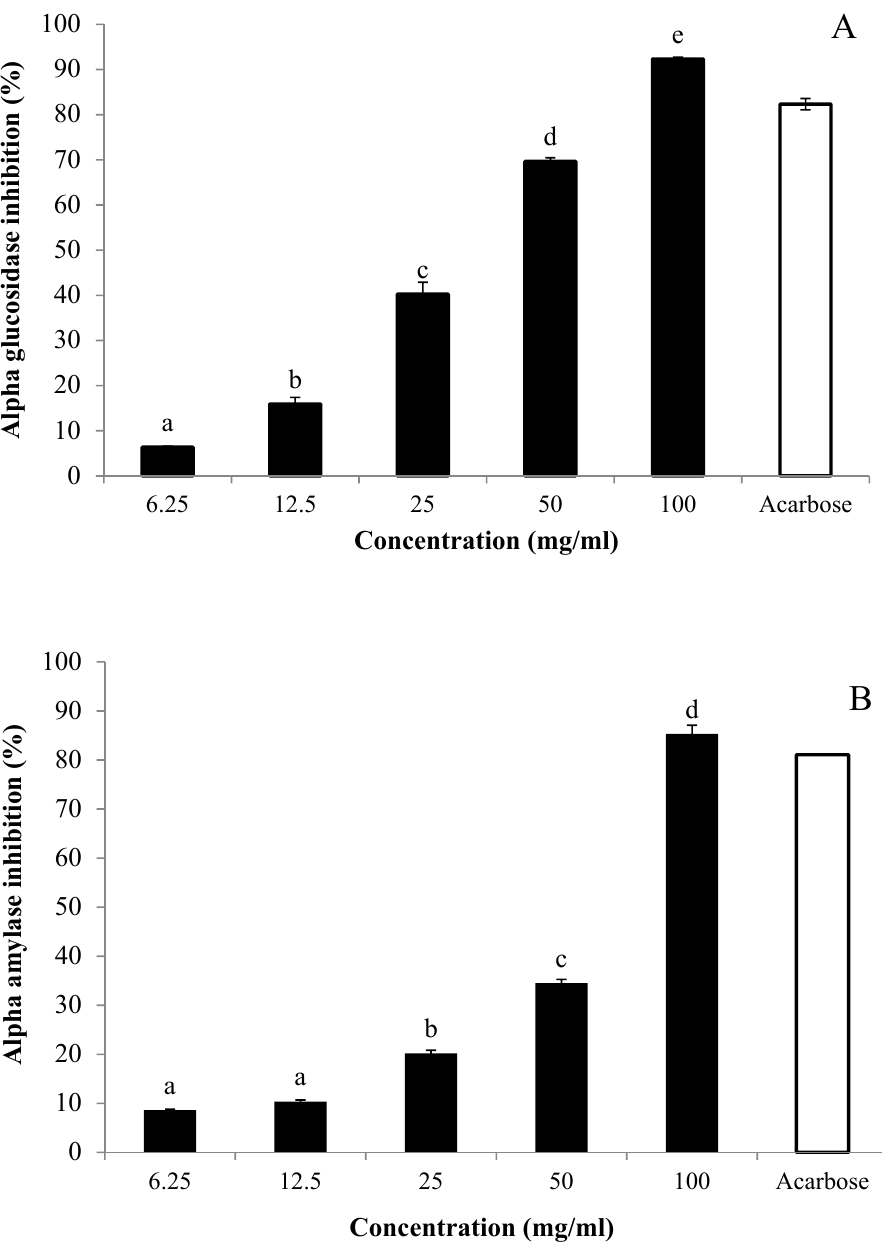
Figure 5. Inhibitory activities of aqueous extract (AE) of NPV on ( A ) α -glucosidase and ( B ) α -amylase. AE inhibitory activities were determined using the respective pNPG and starch as substrates. Acarbose was used as the positive control. Values are expressed as means ˘ S.E.M. of triplicates. Values with different letters of the alphabet were significantly different at p < 0.05, as analyzed using Tukey HSD (honest significant difference) as a post hoc test. The final concentration of acarbose was 6.25